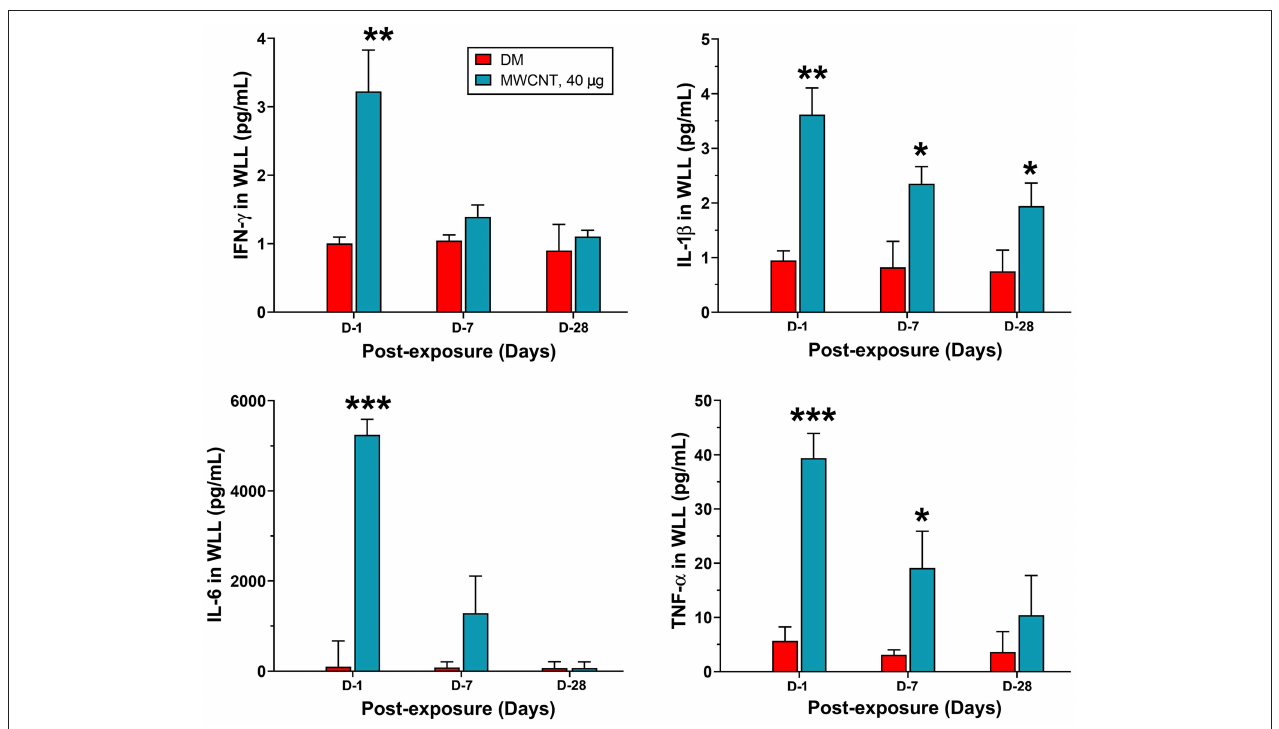
FIGURE 6 | Quantification of proinflammatory cytokines in WLL fluids. Mice were treated as described in Figure 2 legend. At 1, 7, or 28 days post-exposure, mouse WLL fluids were prepared and used to measure IFN- γ , IL-1 β , IL-6, and TNF- α levels by multiplex immunoassays. Data are expressed as mean ± SEM ( n = 6). * p